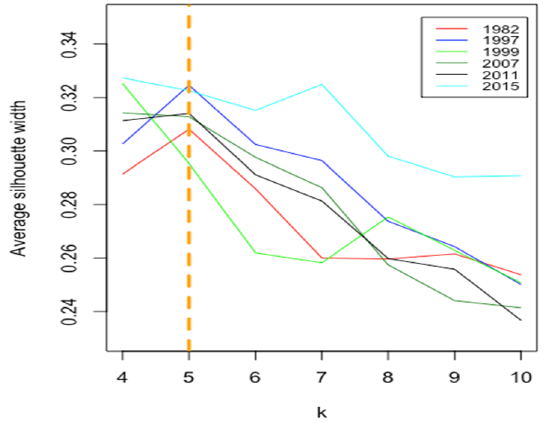
Figure 5. The average silhouette width for spatial cluster analysis by number of clusters and years.